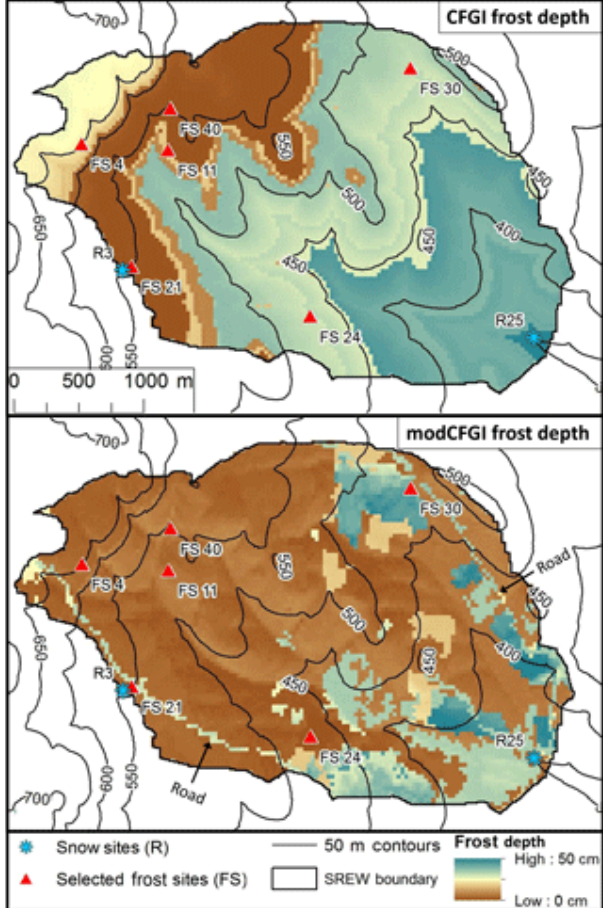
Figure 6. Simulated maps of frost depth (CFGI and modCFGI mod- els) within the W-3 watershed for 23 February 2007. No observed maps of frost depth are available, but the map shows the differ- ences between the temperature-based (CFGI) model and the modi- fied (modCFGI)